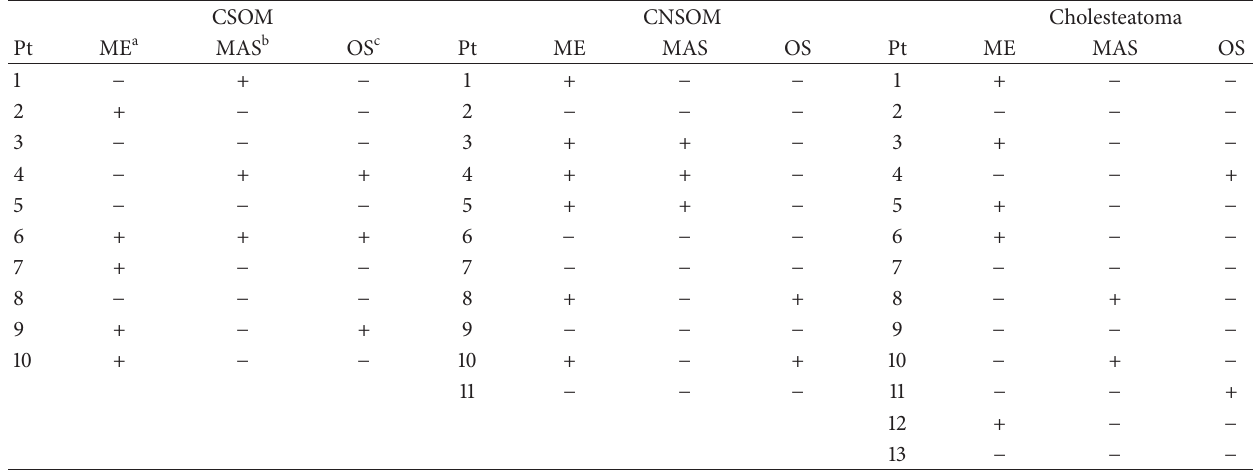
Table 1: The biofilm findings according to the specimen distribution in patient groups. CSOM CNSOM